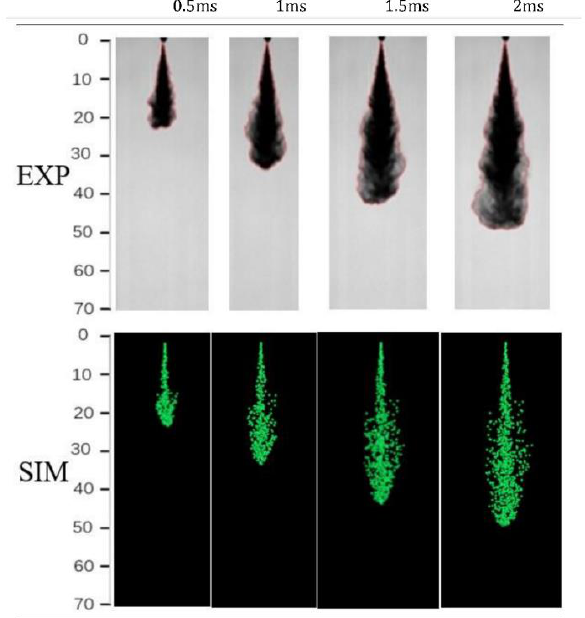
Figure 4. Comparison of experimental and numerical images of spray behavior (injection pulse = 2 ms, injection pressure = 40 MPa, ambient pressure = 3.5 MPa, and ambient temperature = 300 K).